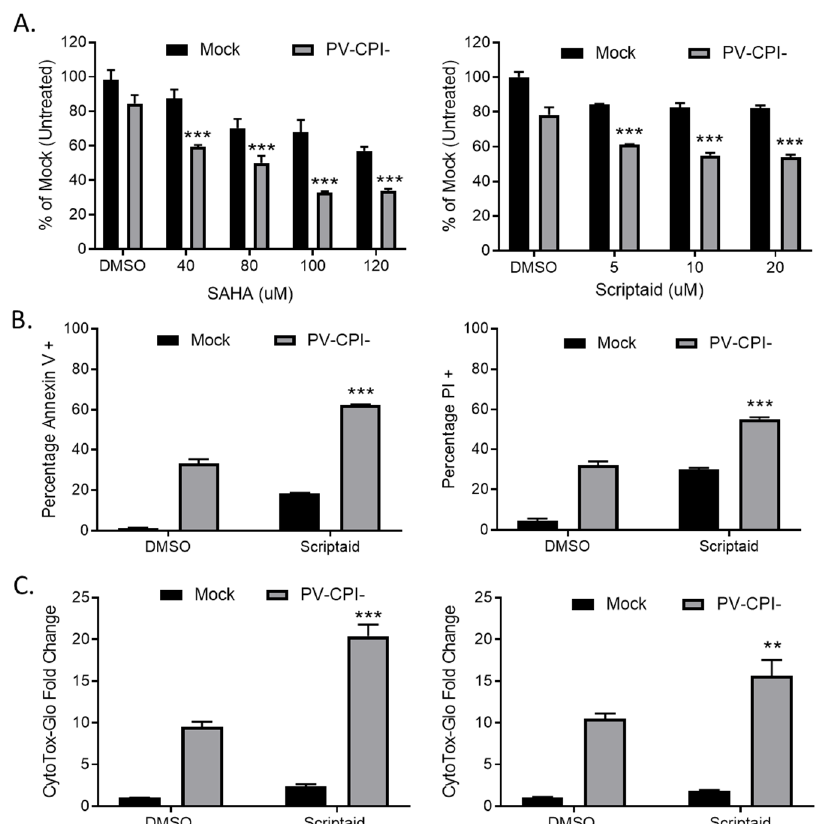
Figure 1. Pretreatment with HDAC inhibitors enhances cell death by the P / V-CPI- mutant virus. ( A ) H1299 cells were pretreated with the indicated concentrations of SAHA (left panel), scriptaid (right panel), or DMSO as a vehicle control for 12 h. Cells were mock infected or infected with the P / V-CPI- mutant at an MOI of 10, and cultured in the presence of the indicated concentration of drugs. After 24 h, cell viability was determined by MTT assay as described in Methods section. ( B ) A549 cells were pretreated with 5 µ M scriptaid or DMSO as a vehicle control for 12 h. Cells were mock infected or infected with the P / V-CPI- mutant at an MOI of 10, and cultured in the presence of 5 µ M scriptaid or DMSO. Cell viability was determined by annexin V (left panel) and PI staining (right panel) at 24 hpi. ( C ) H1299 (left panel) or A549 (right panel) cells were pretreated with 20 µ M scriptaid or DMSO for 12 h before mock infection or P / V-CPI- infection at an MOI of 10. After culturing in the presence of 1 µ M scriptaid or DMSO for 24 h, cytotoxicity was determined by CytoTox-Glo assay. Values in all panels are the mean of three replicates normalized to DMSO pretreated mock infected samples with error bars indicating standard deviation. ** and *** indicates p -value of < 0.01 and < 0.001 comparing DMSO versus HDAC inhibitor pretreated infected samples.